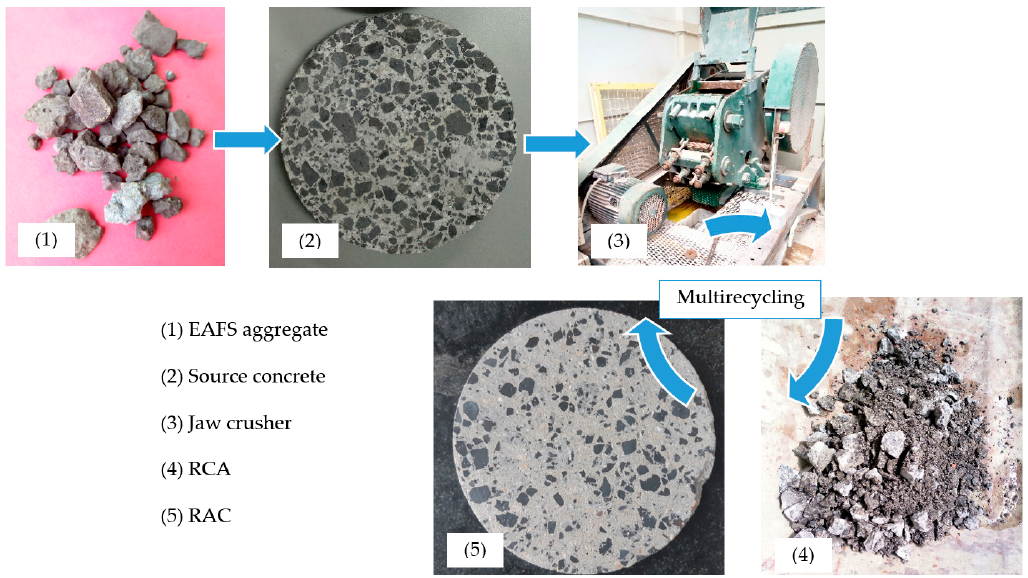
Figure 2. Recycled aggregate concrete (RAC) manufacturing process.